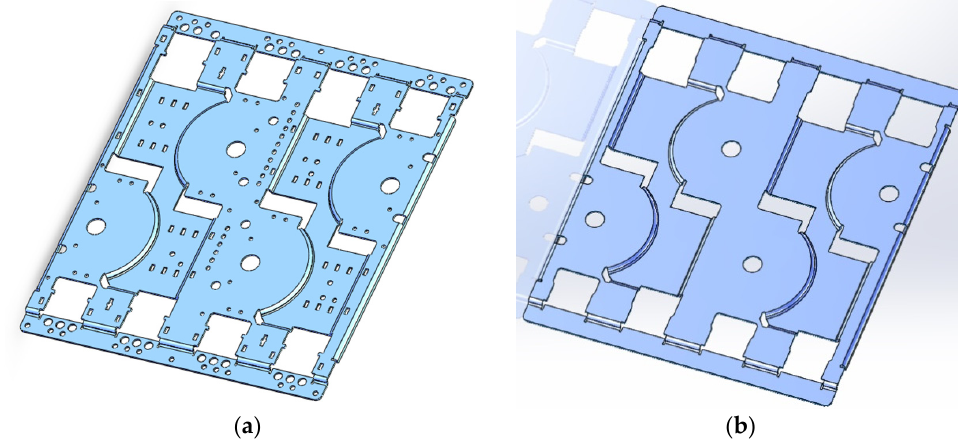
Figure 7. An example of simplifying the simulation model ( a ) the original model of a phase shifter plate ( b ) the simplified model of the phase shifter plate.